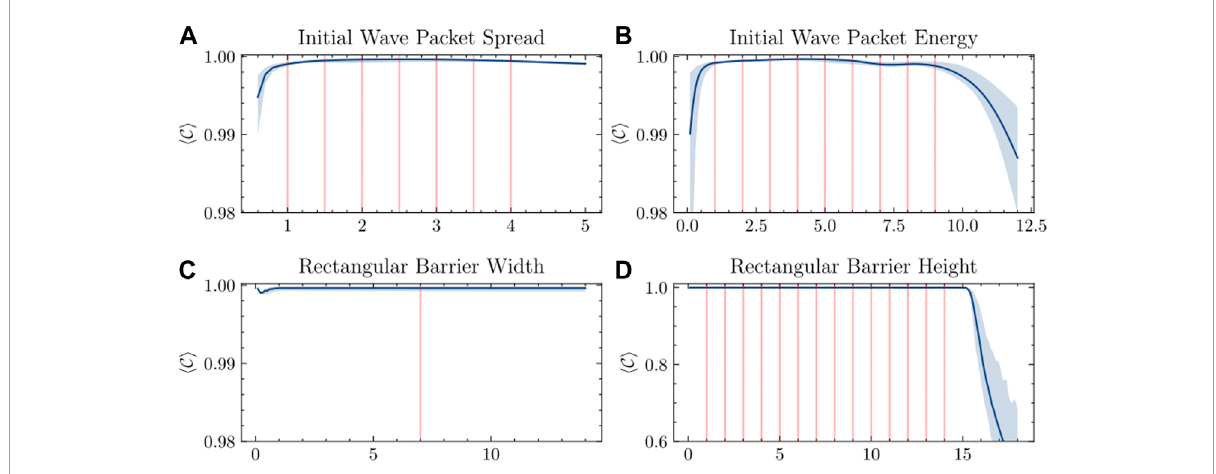
FIGURE 6 Generalization of Simulation Parameters. Average normalized correlations, denoted by ⟨ C ⟩ , as functions of four simulation parameters: (A) initial wave packet spread, (B) initial wave packet energy, (C) rectangular barrier width, and (D) rectangular barrier height. We repeated each experiment using five different random seeds. The bold blue line in each panel shows the average normalized correlation, and the blue shades indicate the span between the minimum and maximum values recorded in those five trials. The red vertical lines denote the training values for each emulation